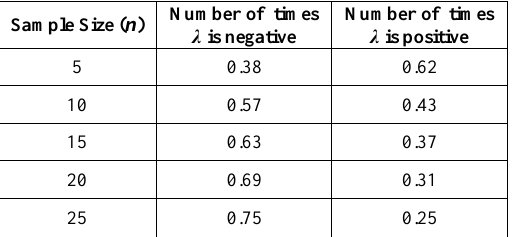
Table 1. Proportion of negative and positive λ ’s